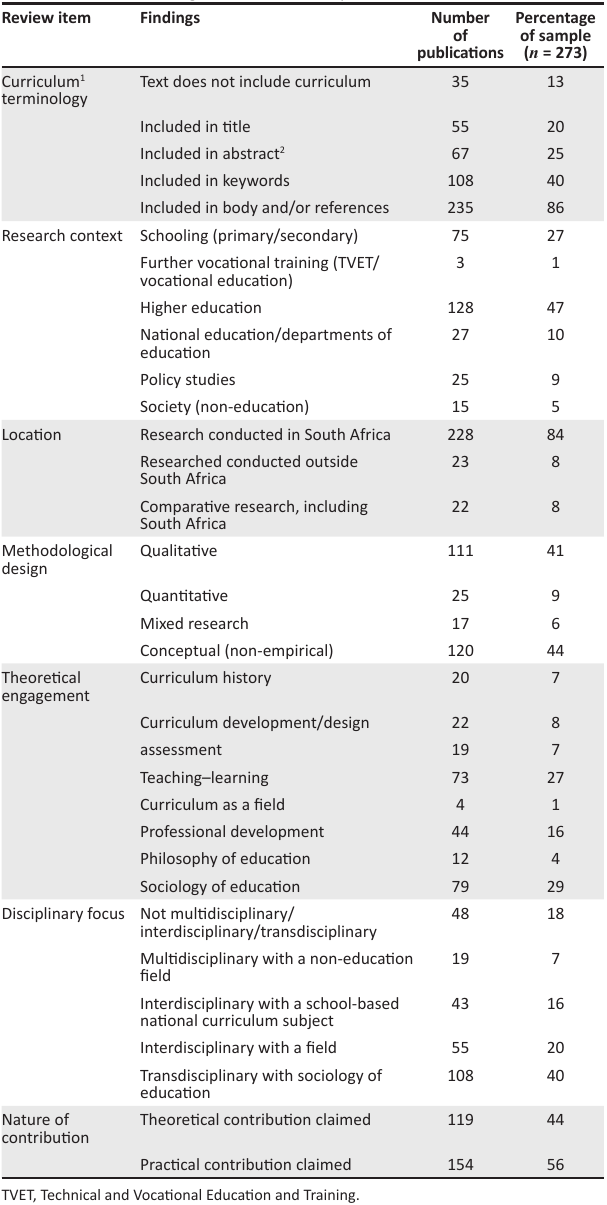
TABLE 1: Research findings from the review